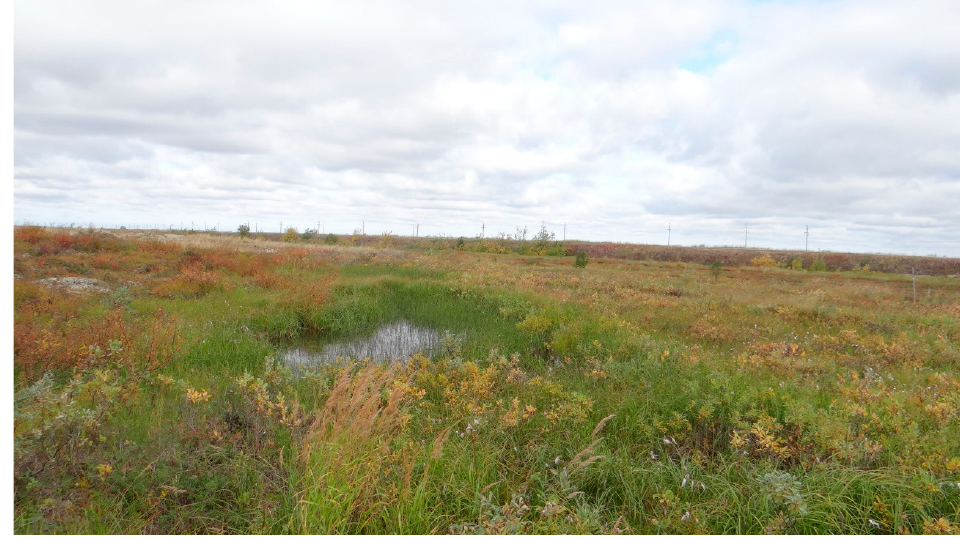
Figure 9. Photo of the bottom of a degraded thermokarst pond.